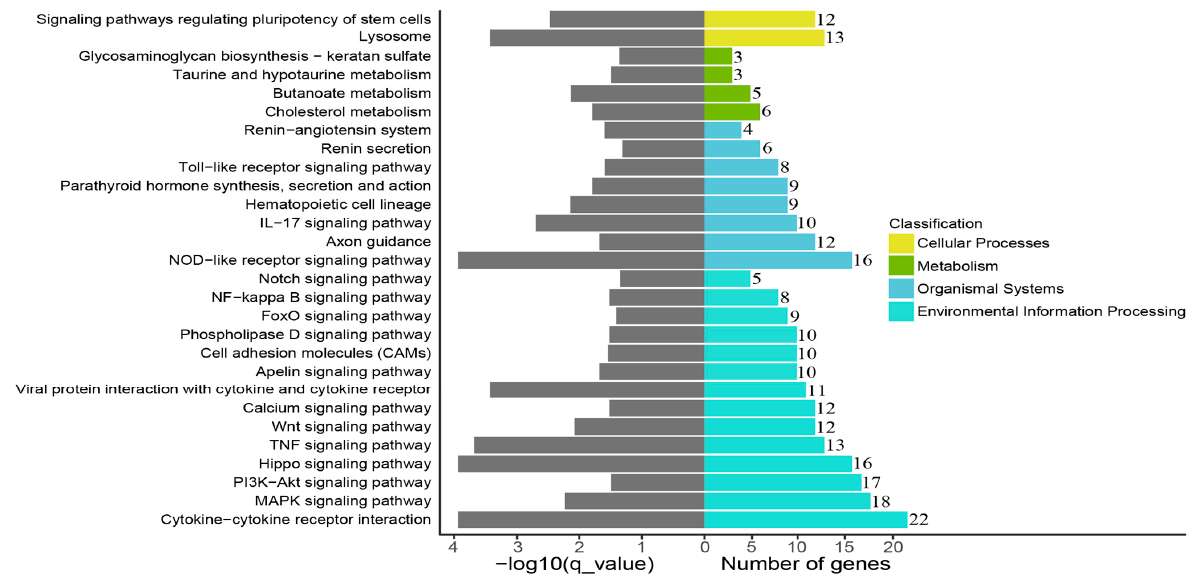
Figure 5. KEGG-pathway enrichment analysis of